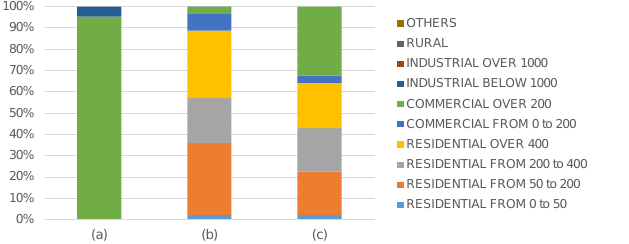
Figure 9. Representation of the groups formed by clustering: ( a ) Group 1, ( b ) Group 2, and ( c ) Group